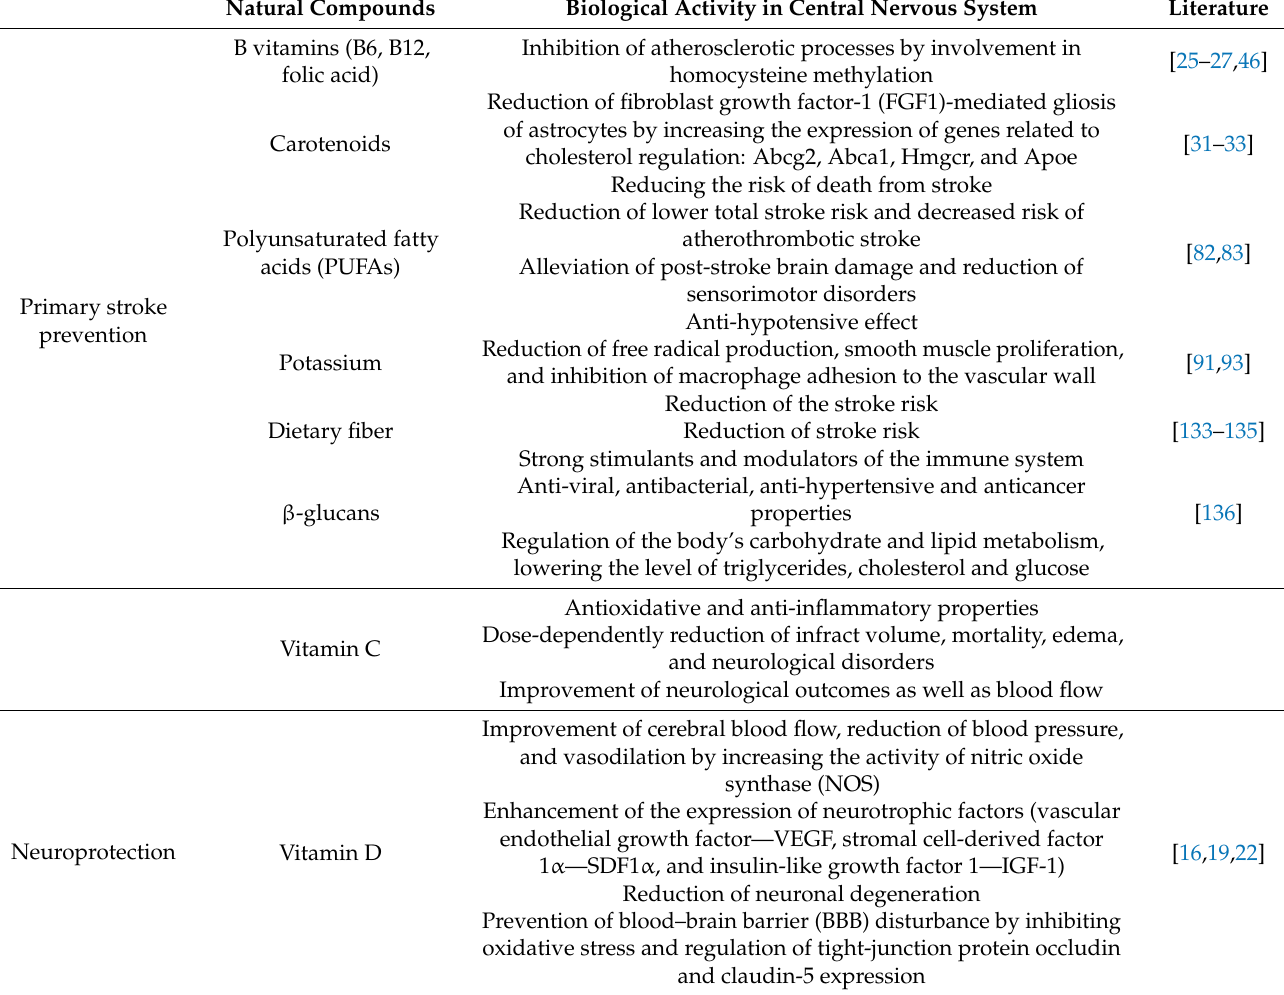
Table 1. The participation of natural compounds in primary prevention of stroke and supporting post-stroke recovery. Natural